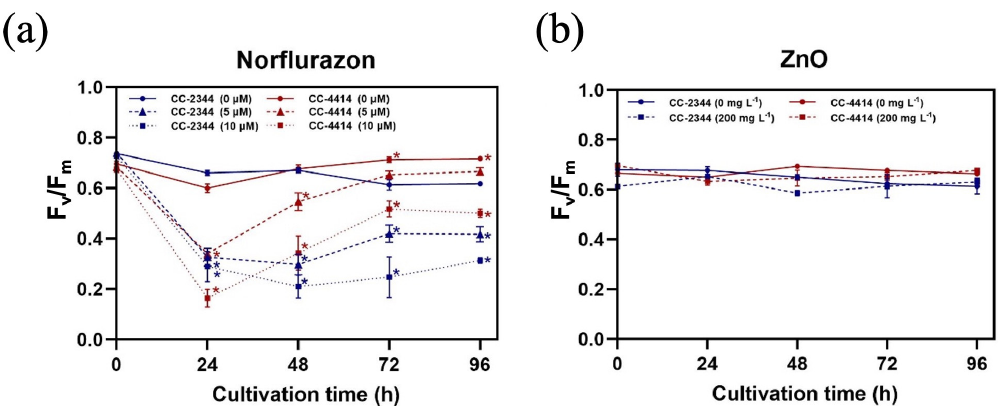
Figure 3. Chlorophyll fluorescent parameter. The maximum quantum yield of PSII (F v /F m ) under the presence of norflurazon ( a ) and ZnO NPs ( b ). Blue and red solid lines are CC-2344 and CC-4414 with no chemicals, respectively. Blue and red dashed lines and dotted lines represent CC-2344 and CC-4414 with the indicated concentration of the chemical, respectively. All data are means ± SD of three biological replicates. All data are means ± SD of three biological replicates. Significant differences between the control culture and the chemical-added culture within the same condition are indicated by asterisks (*) ( p < 0.05).